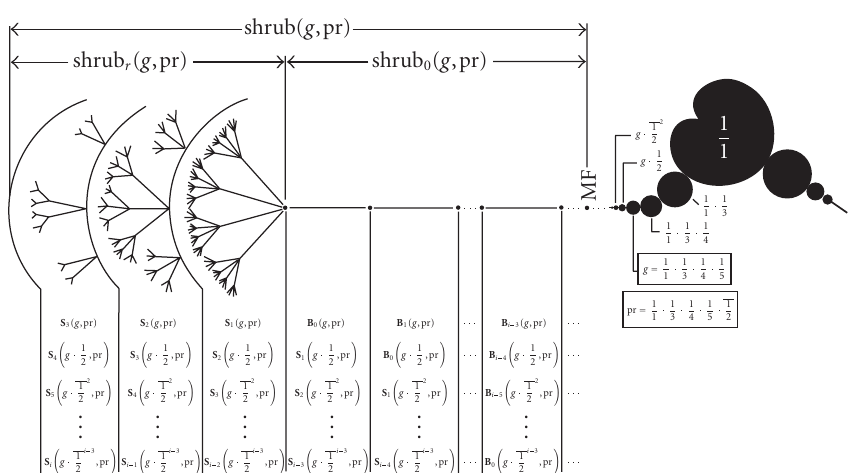
Figure 5.2. Sketch of the tertiary route through the tertiary hyperbolic component 1 / 1 · 1 / 3 · 1 / 4 · 1 / 5, showing the periodic route and the chaotic route, shrub(1 / 1 · 1 / 3 · 1 / 4 · 1 / 5,pr). The lower part shows a table with di ff erent names of each chaotic